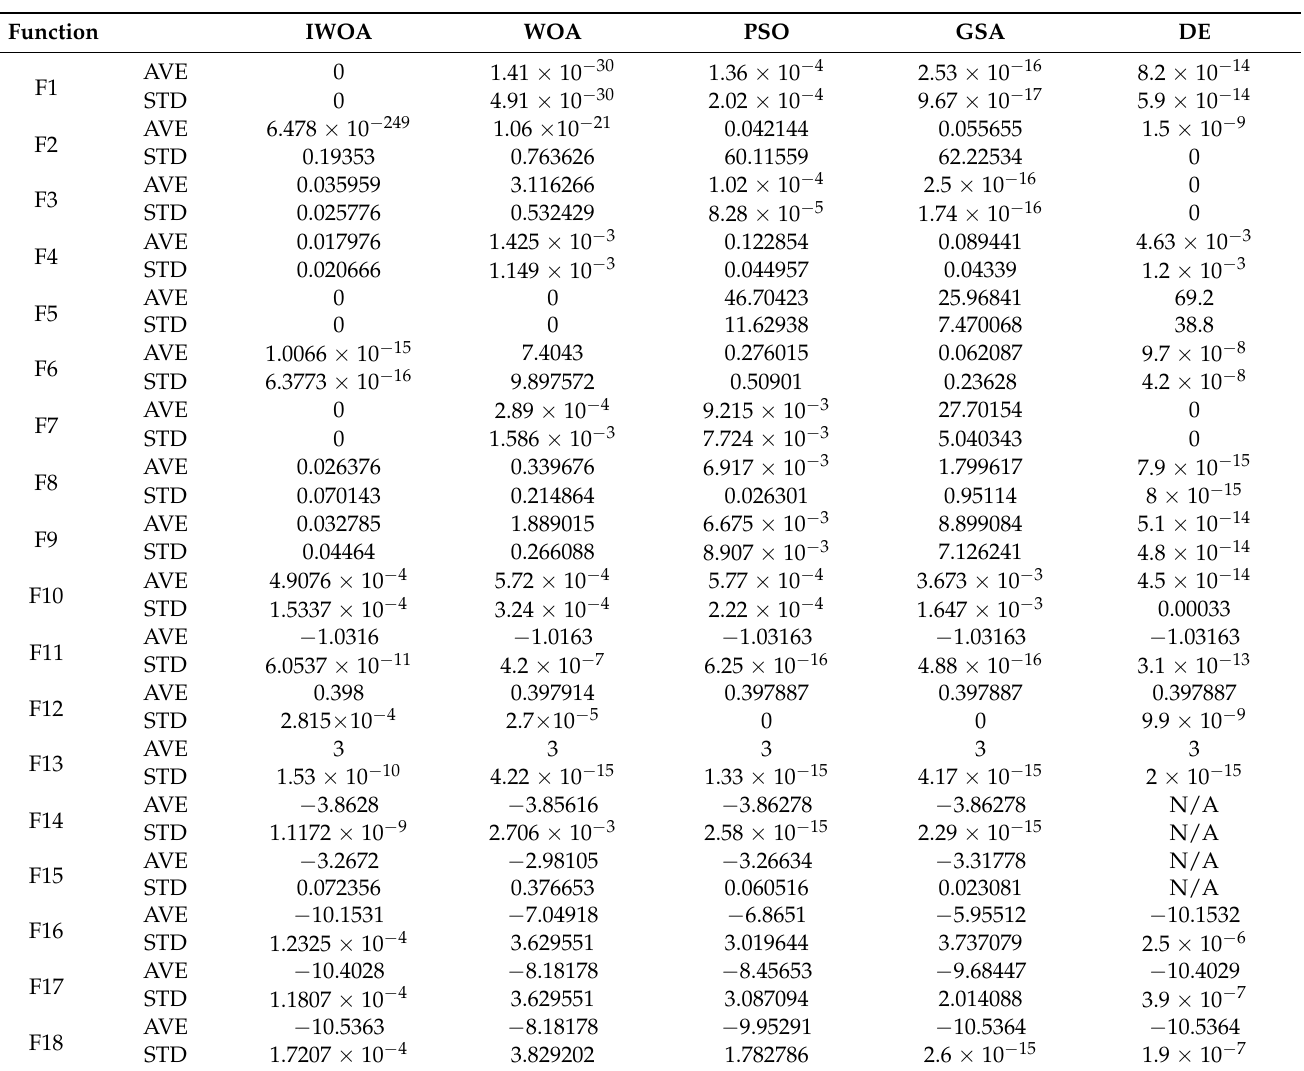
Table 2. Comparing IWOA with the performance of other